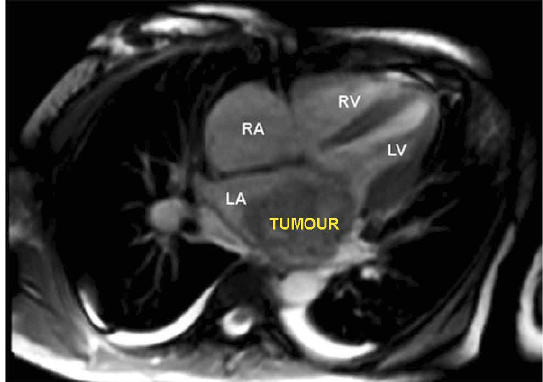
Figure 2. Cardiovascular magnetic resonance image of the tumor in the left atrium (LA). RA, right atrium; RV, right ventricle.